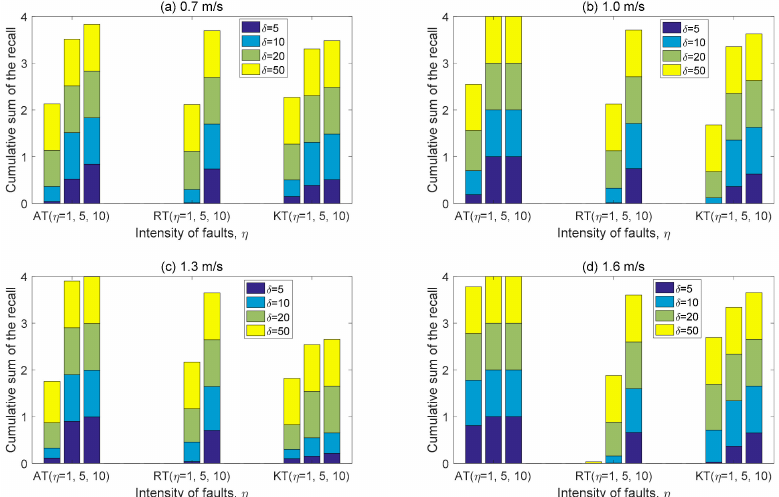
Figure 8. Recall according to each duration as a function of random fault intensity: ( a ) Cumulative sum of the recall at 0.7 m/s of Jackal UGV; ( b ) Cumulative sum of the recall at 1.0 m/s; ( c ) Cumulative sum of the recall at 1.3 m/s; ( d ) Cumulative sum of the recall at 1.6